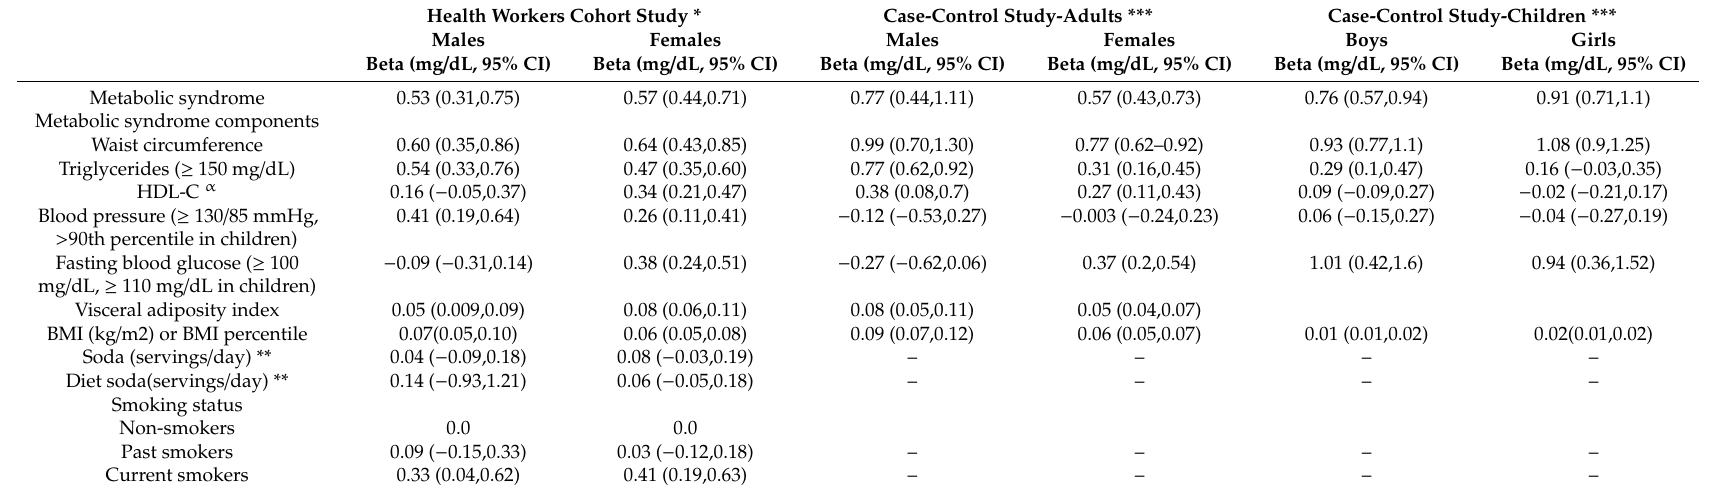
Table 2. Association between metabolic syndrome, its components, diet, and smoking with serum uric acid